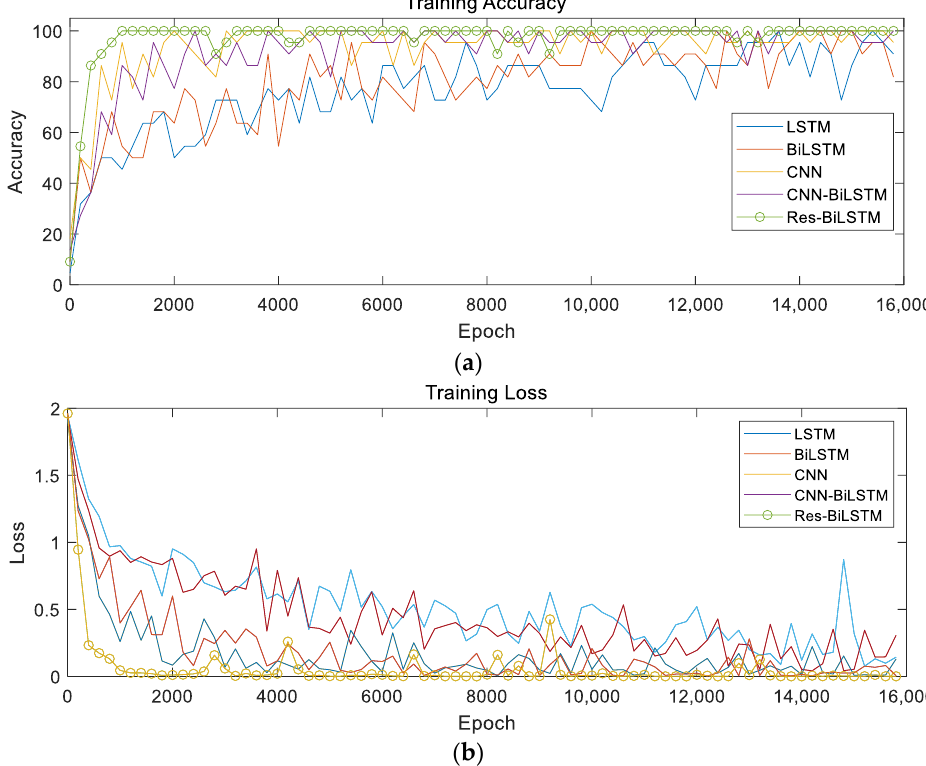
Figure 12. Comparison of training effects under 5 deep learning frameworks: ( a ) Training Accuracy comparison; ( b ) Training Loss comparison.